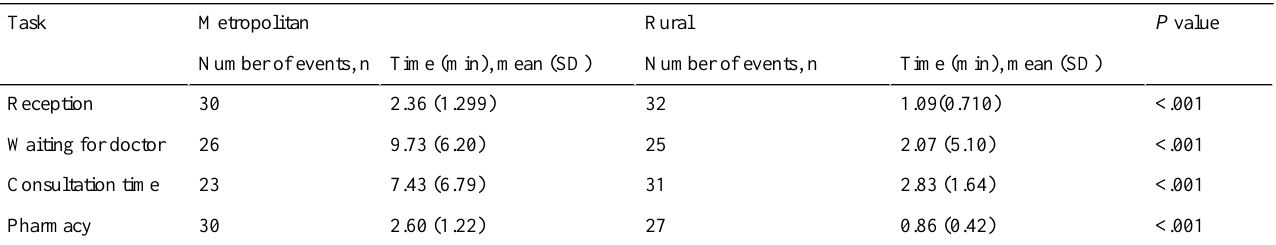
Table 2. The time per task for primary health care centers located in metropolitan areas versus primary health care centers located in rural areas.